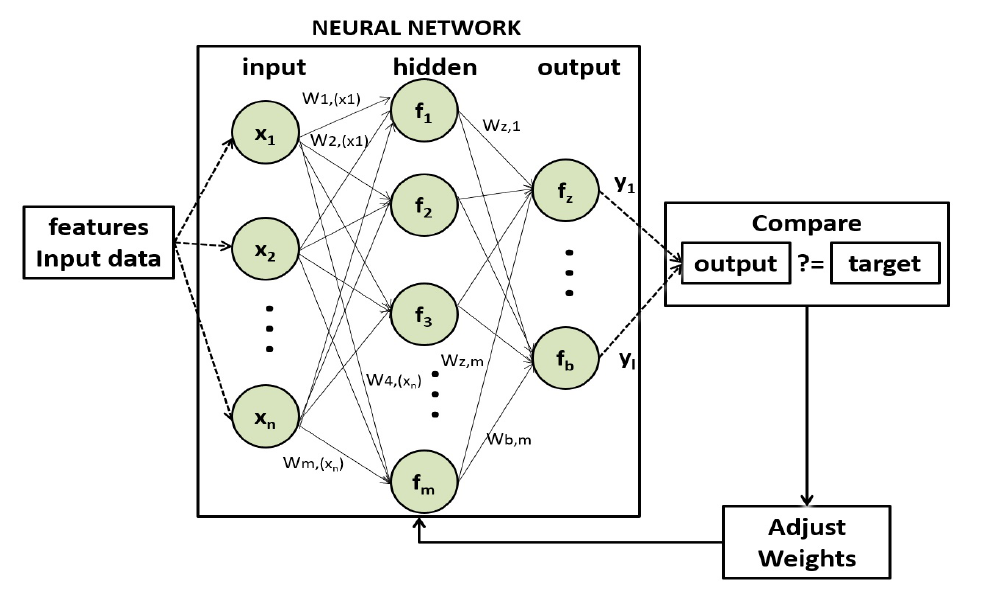
Figure 1. The back-propagation training process for neural